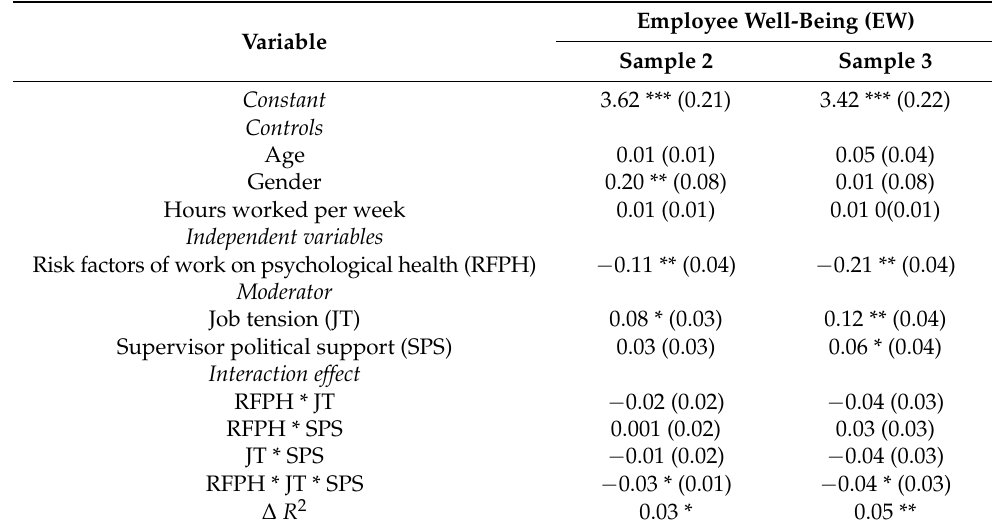
Table 3. Results of three-way interaction of risk factors of work on the psychological health of work predicting employee